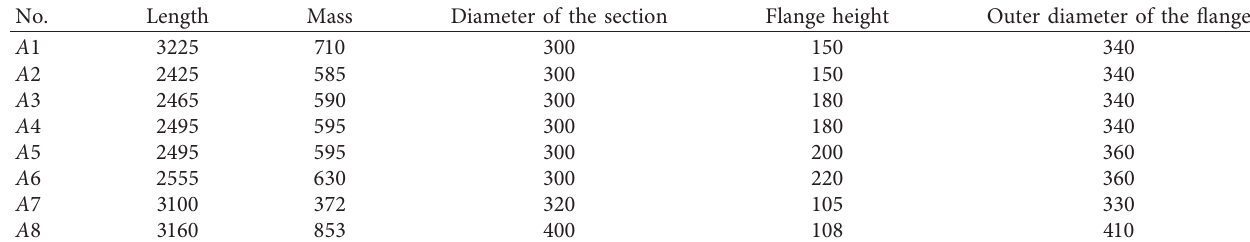
Figure 1: Schematic diagram of the test piece assembly. (a) ± 1,100kV insulator assembly drawing, (b) ± 800kV arrester assembly drawing, (c) flange connection parameters. Table 1: Parameters of individual insulators.